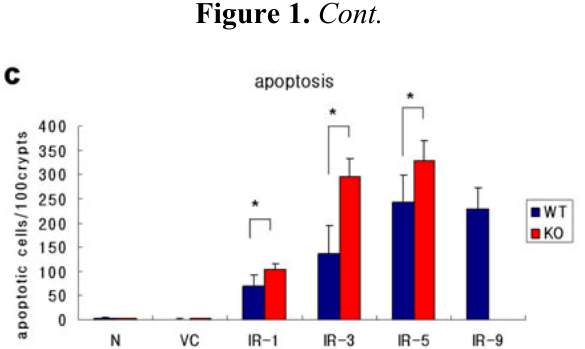
Figure 2. ( A ) Detection of apoptosis in the crypts of the intestine by terminal deoxynucleotide transferase labelling of DNA strand breaks (TUNEL) in the WT mice. N, normal control; VC, vitamin C; Gy, Gray; Original magnification 1000×, Bars = 20 μ m; ( B ) Detection of apoptosis in the crypts of the intestine by terminal deoxynucleotide transferase labelling of DNA strand breaks (TUNEL) in SMP30 KO mice. N, normal control; VC, vitamin C; Gy, Gray; Original magnification × 1000, Bars = 20 μ m; ( C ) Positive cells were quantified in the sections stained with the TUNEL method. Values represent the mean ± SD in each group. WT, wild type; KO, knock out. *